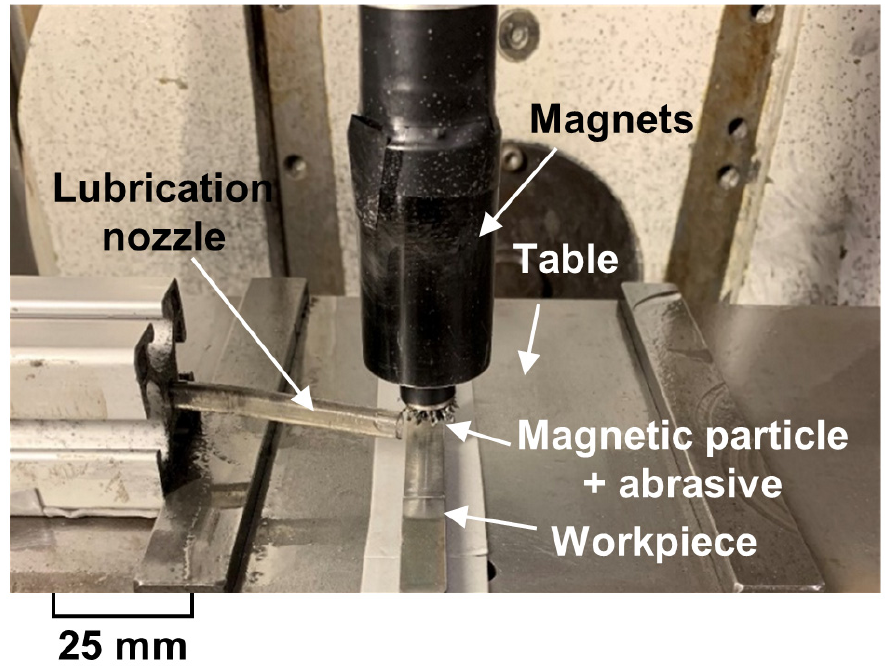
Figure 2. MAF polishing